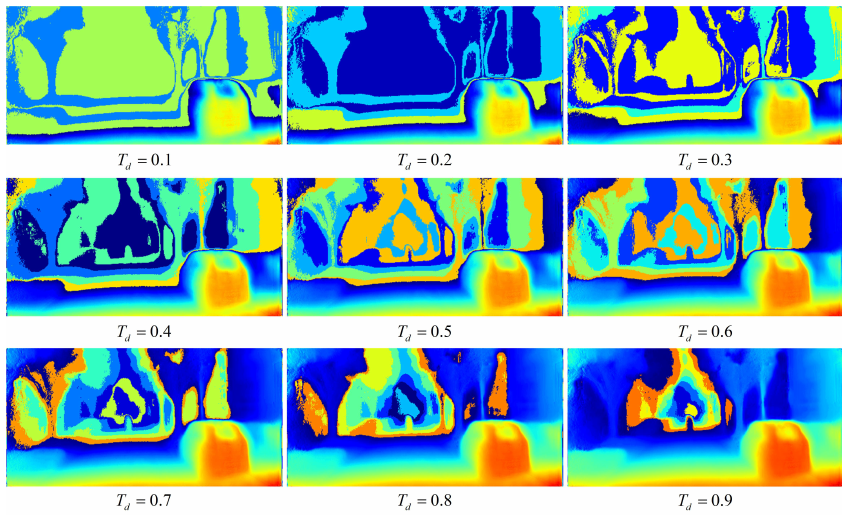
Figure 9. Depth attentive heat map with different T d